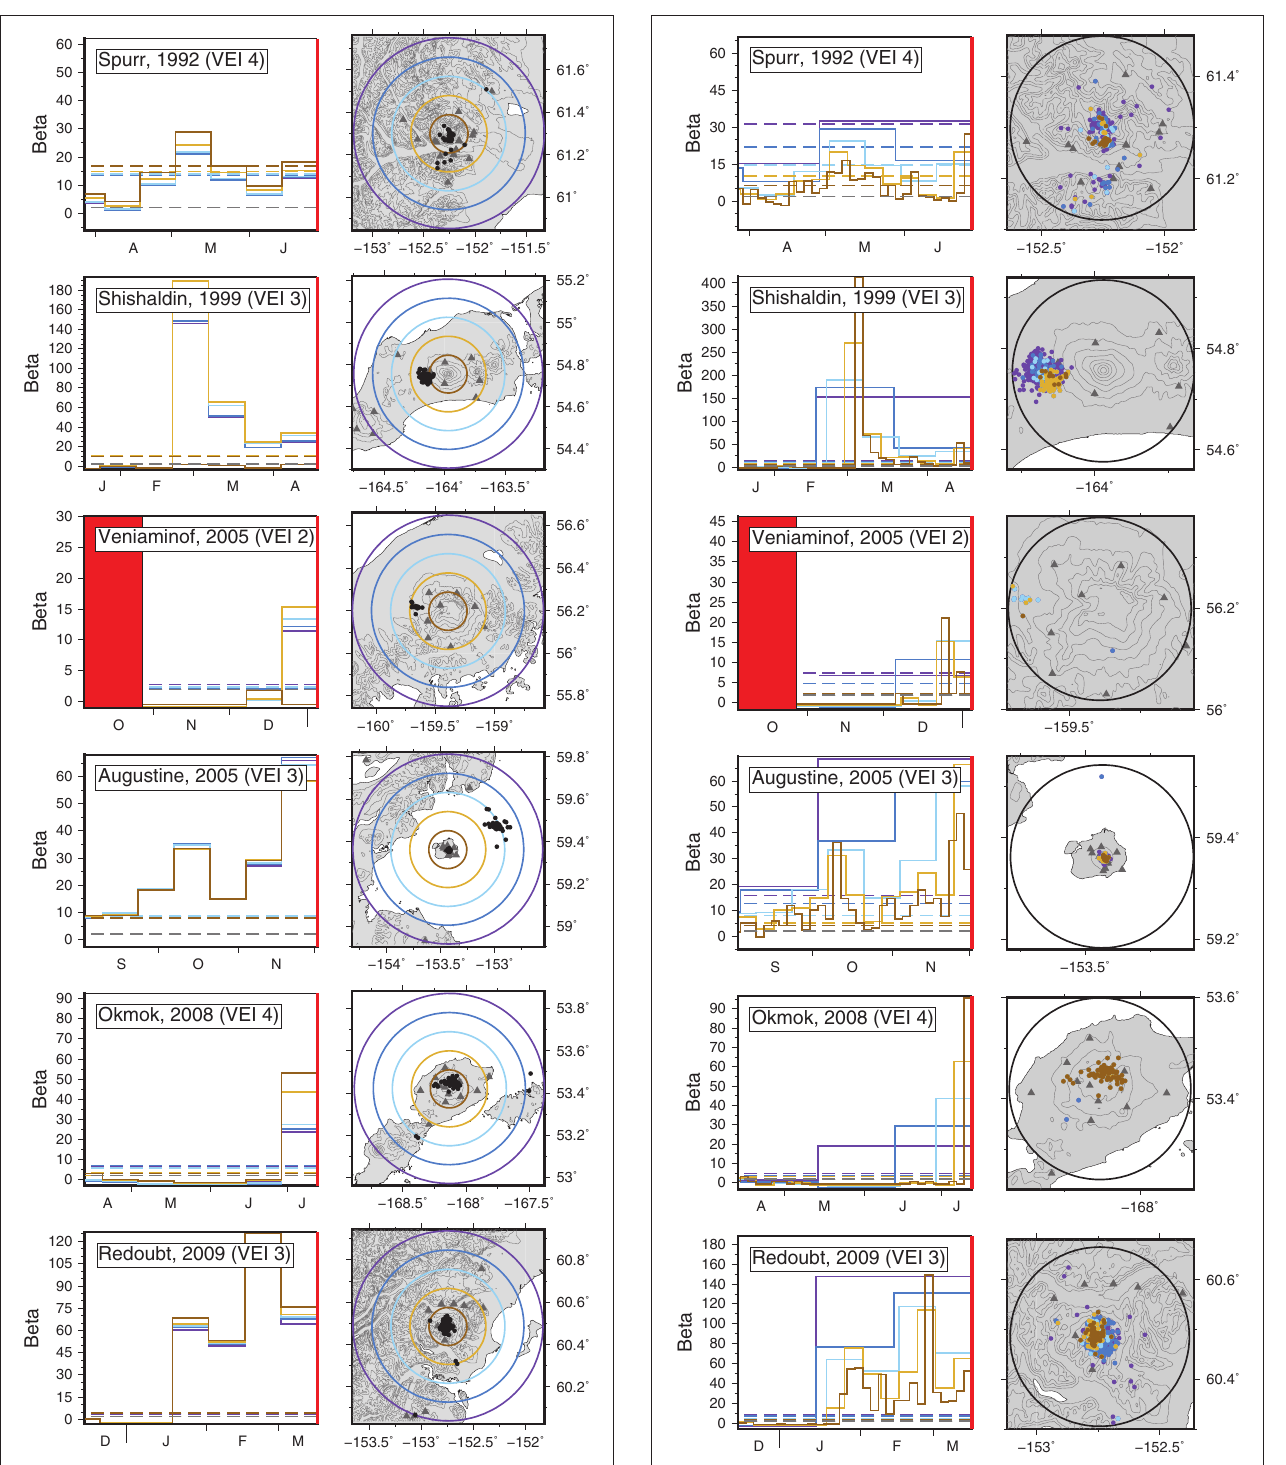
FIGURE 5 | Results of the β -statistic test for a range of T a day values = 3, 7, 14, 30, 60 (brown, yellow, light blue, dark blue, purple). R = 20km for all results shown. X-axes show the 3 months prior to the eruption. Y-axes are scaled by the maximum anomaly seen over the entire time period analyzed (see Figure 7 ). Maps show events within T a days of eruption. See Figure 2 and text for additional